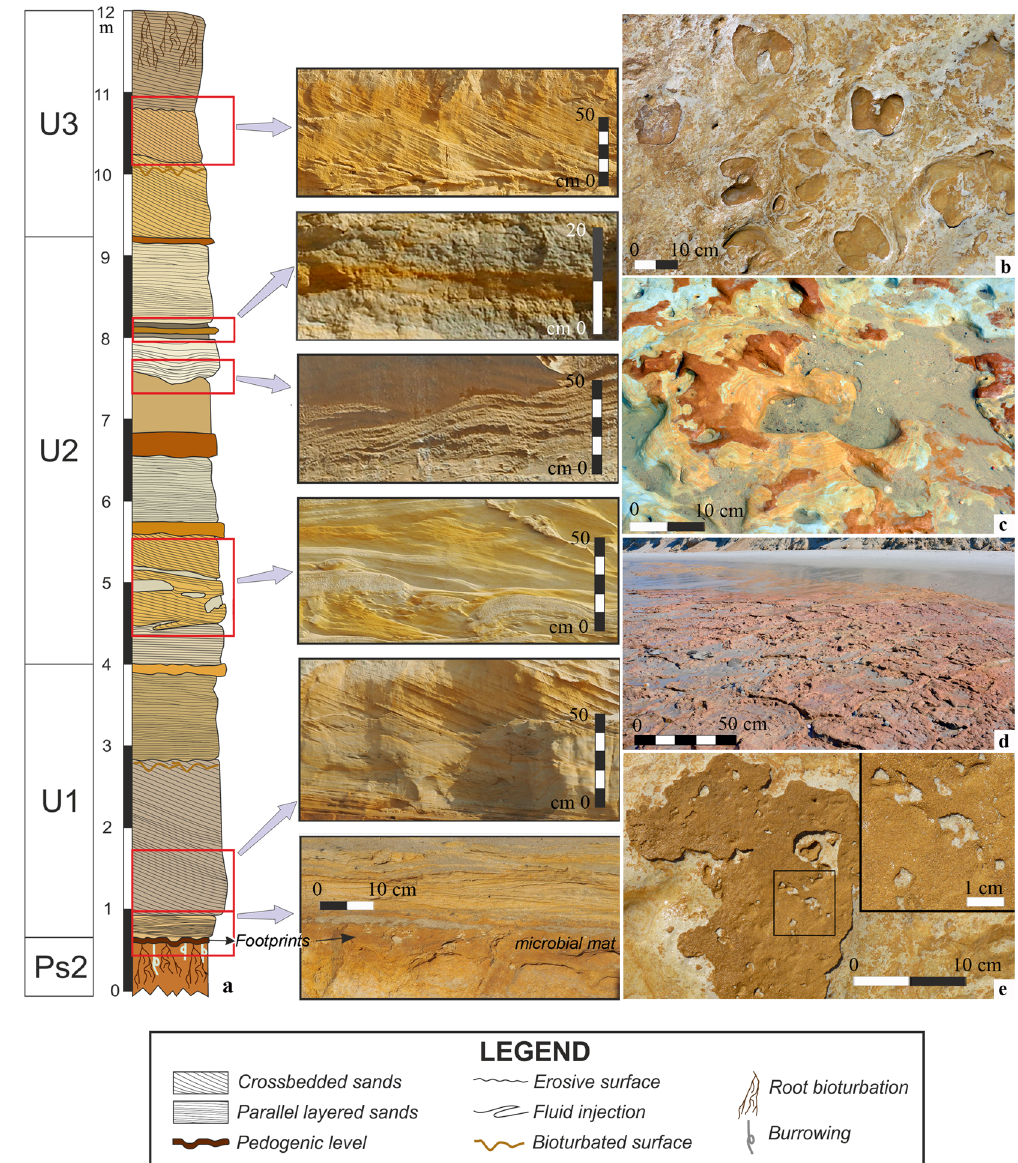
Figure 2. ( a ) Sedimentary log of the Asperillo Cliff in the framework of the units distinguished by Zazo et al. 22 . The right border of the sedimentary bodies in the log indicates the relative changes of the average grain-size. The colors of the bodies represent the approximate real color of the sediments. At the right of the column, pictures illustrate the aspect of some of the sedimentary bodies. ( b ) Detailed view of the MTS with several Artiodactyla tracks. ( c ) Detail of palaeosol Ps2 showing concentric structures and transitions of several colors related to root activity. ( d ) Ferruginized microbial mat overgrown and filled wide polygonal cracks. e. External halite moulds on the ferruginized microbial